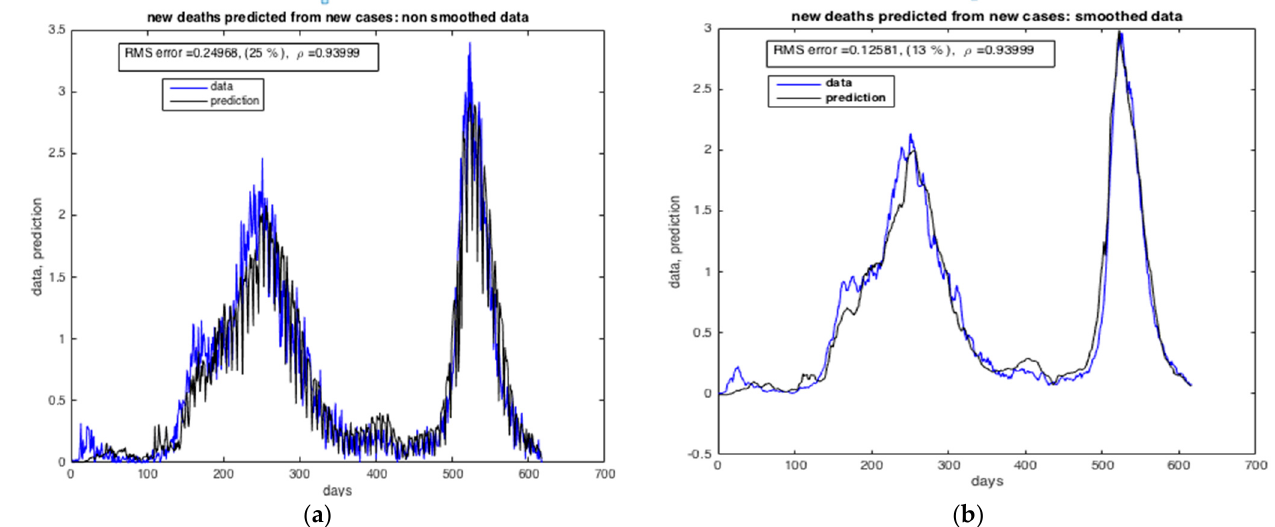
Figure 17. Estimation of the number of deaths by SARS-CoV-2 in Morocco predicted from the number of infected cases. ( a ) Non-smoothed data. ( b ) Smoothed data. The results furnished by collocation method.